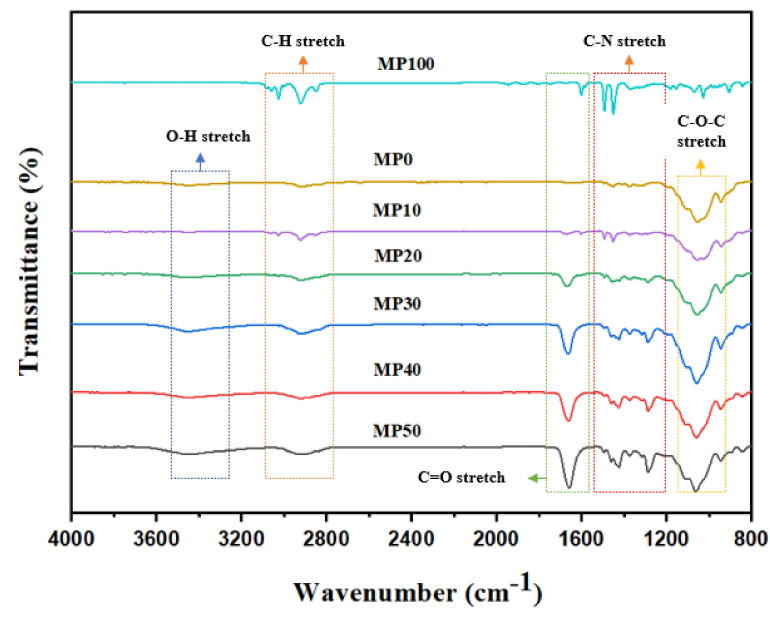
Figure 3. FTIR of MC/PVP polymer